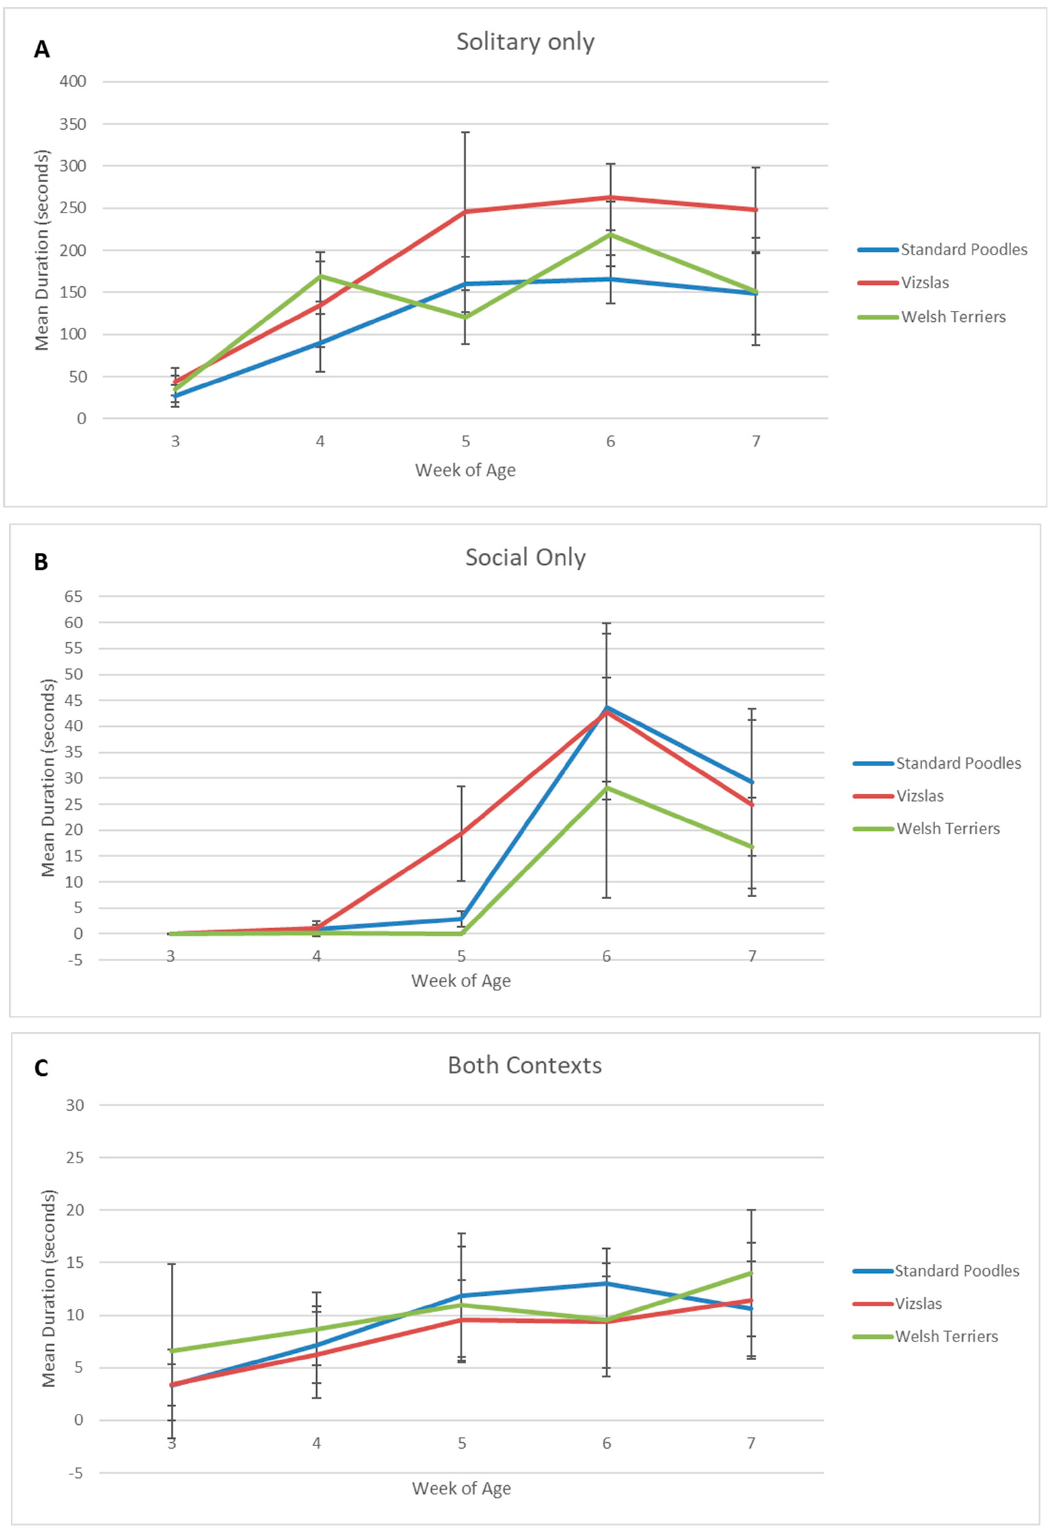
Figure 2. Play Context. Mean durations in seconds for individual pups across breeds for each play context: play behaviors performed ( A ) only by a solitary animal (solitary/SOL); ( B ) only by two or more individuals (social/SOC); and ( C ) those that were observed in either solitary or multiple individual contexts (both/BOTH) by age in weeks 3–7 with 95% CI.